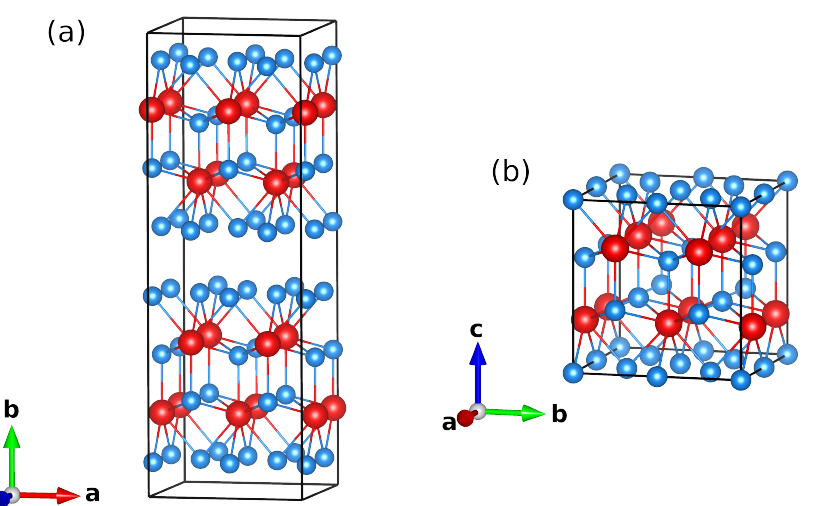
Figure 1. The crystal structures of ( a ) RTe 3 and ( b ) RTe 2 . The red balls represent the rare-earth atoms, while the smaller blue balls represent the tellurium atoms. As the figure shows, RTe 3 structure consists of a stack of alternating double RTe layers and double Te layers. In RTe 2 , double RTe layers alternate with single Te